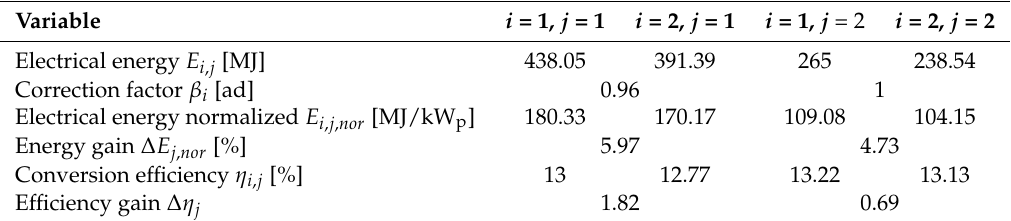
Table 1. PV arrays’ energy production and conversion efficiency during the first ( j = 1) and second ( j = 2)